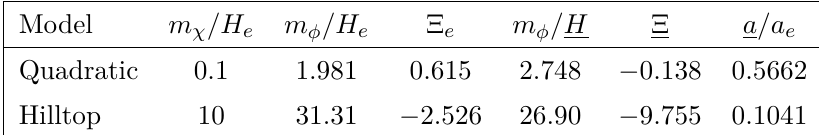
Table 1 . Values in the Quadratic and Hilltop models of inflation defined by eqs. (2.3) and (2.4), respectively. Note that dividing a/a e by ( H e /m φ ) 2 / 3 gives 0 . 893 and 1 . 034 for the respective models, which are O (1) , as expected based on the definition of a in eq.